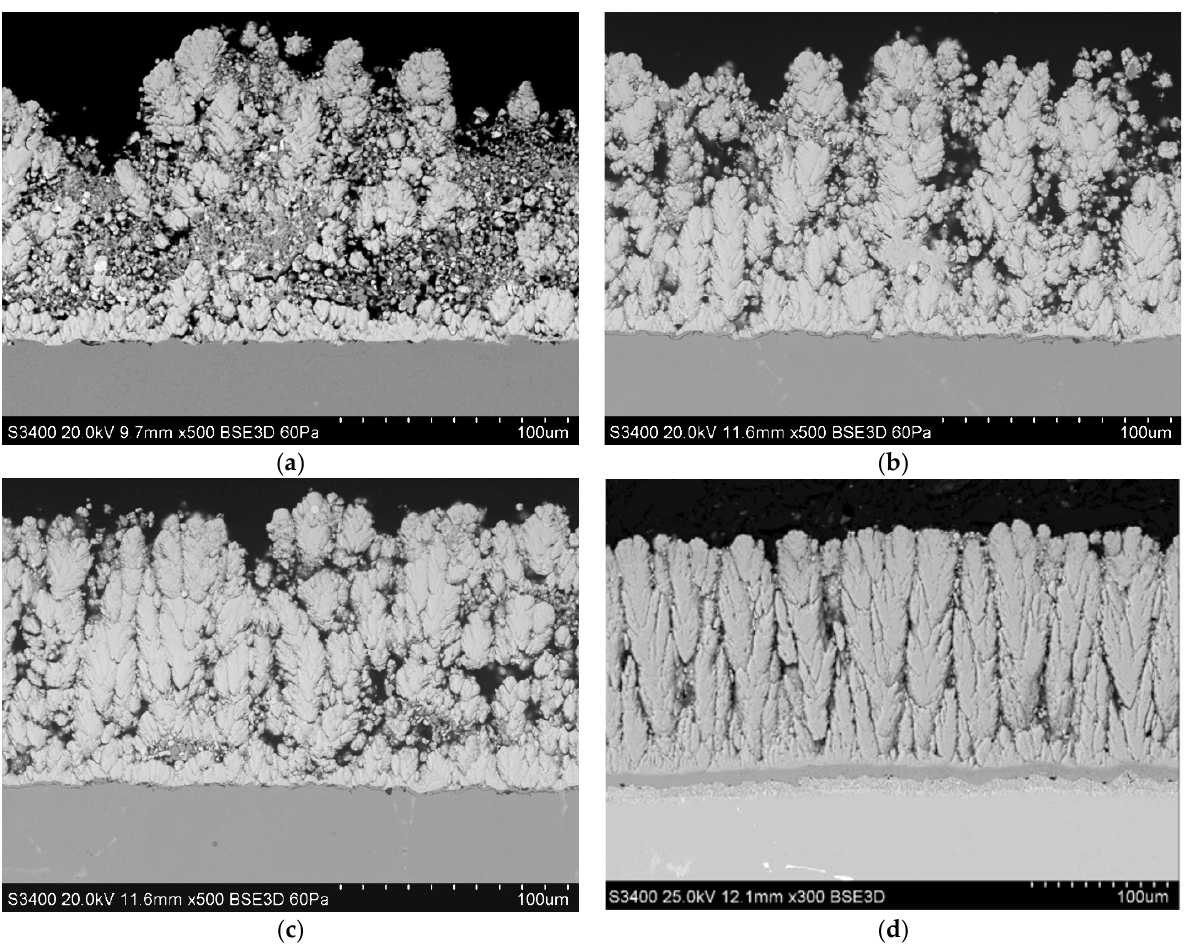
Figure 1. Microstructures of Gd 2 Zr 2 O 7 (GZO) layers made with different power current values: ( a ) GZO-1800A, ( b ) GZO-2000A, ( c ) GZO-2200A and microstructure of conventional YSZ-2200A layer ( d ).